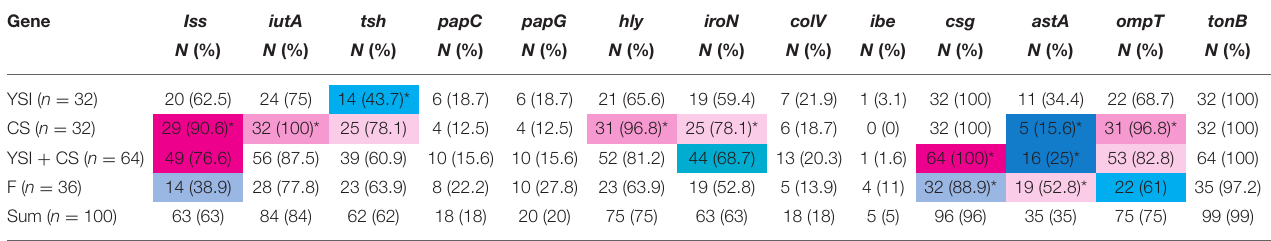
TABLE 1 | Distribution of virulence-associated genes among avian Escherichia coli strains isolated from yolk sac infection, coliseptocemia, and fecal samples. Gene Iss iutA tsh papC papG hly iroN colV ibe csg astA ompT tonB